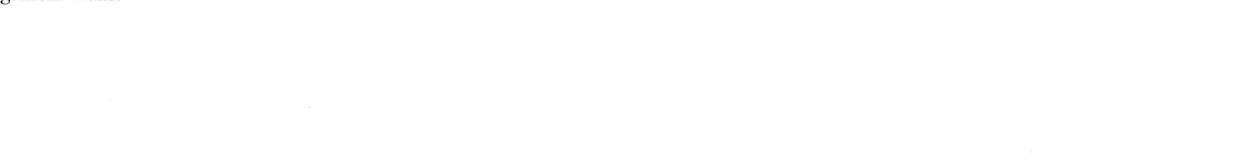
Figs. 1-4. - Macrogamonts of Sarcocystis singaporensis in gut epithelial cells. 1. Young macrogamont, protrusions of the PV wall sloughing off into the lumen (white arrows). 2. Young macrogamont with elongate nucleus, Golgi-like organelle and food vacuole. 3. Growing macrogamont, already with formed wall-forming-like bodies. 4. Mature macro gamont, already with cisternal or canalicular spaces, PV is filled with granular matrix with electron dense deposits along the PV and the macrogamont